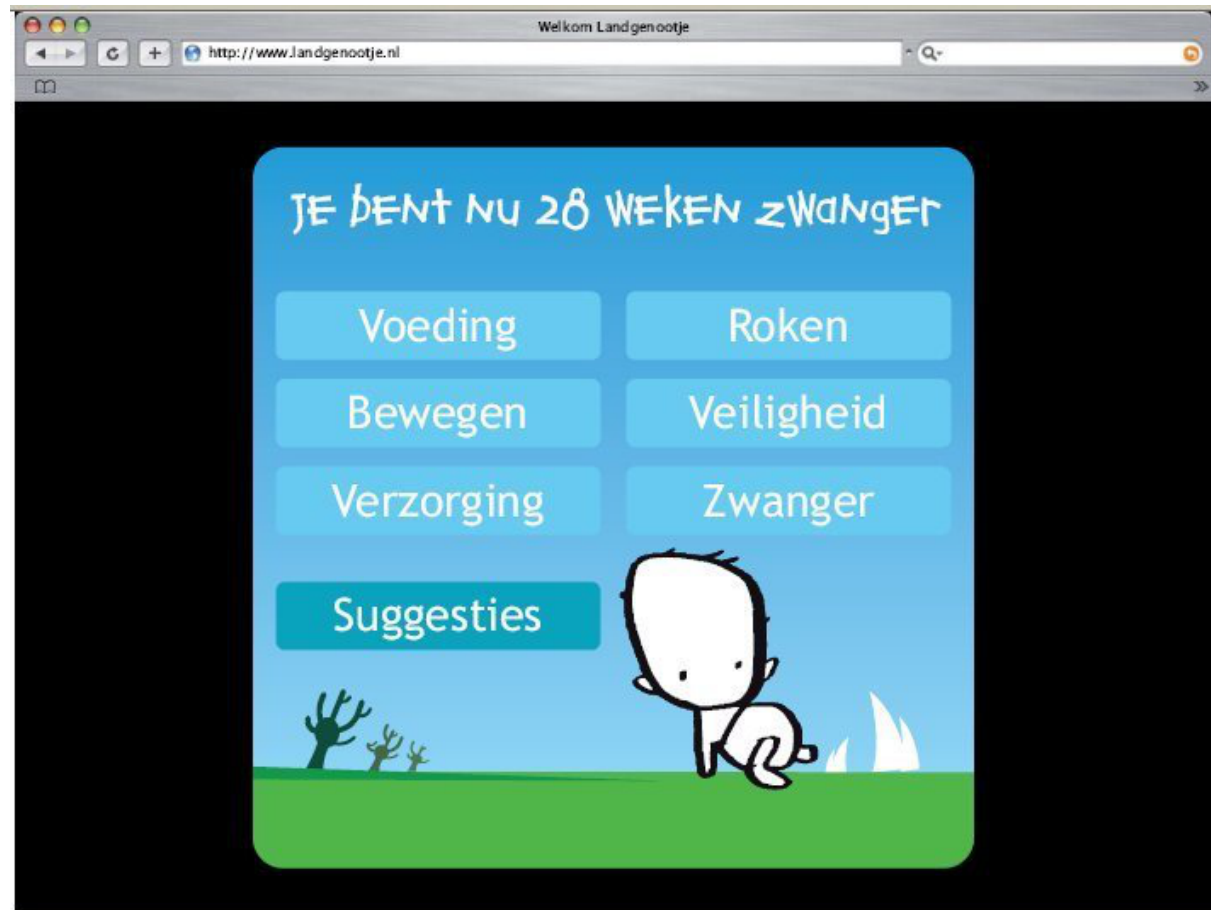
Figure 1. Screenshot of the